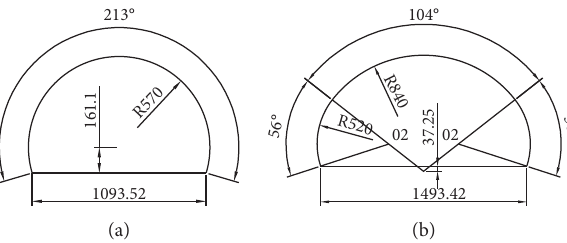
Figure 2: (a) Cross section of two-lane tunnel (unit: cm). (b) Cross section of three-lane tunnel (unit: